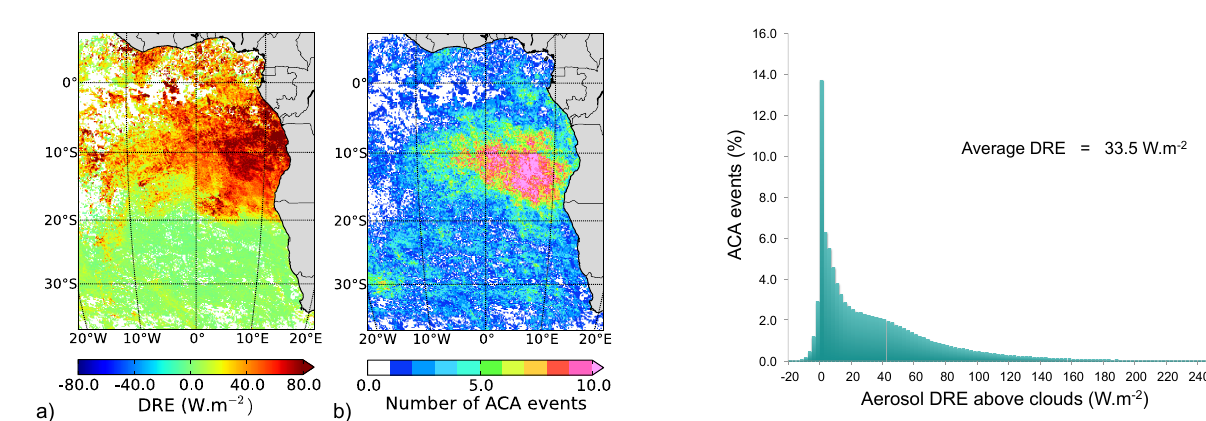
Figure 10. DRE of aerosols above clouds averaged during Au- gust 2006 (a) and number of associated events (b) . The DRE has been processed over area with a cloud fraction (CF) equal to 1 and COT ≥ 3.